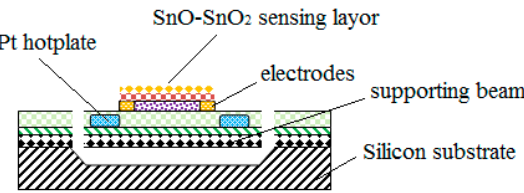
Figure 3. A schematic representation of the whole structure.